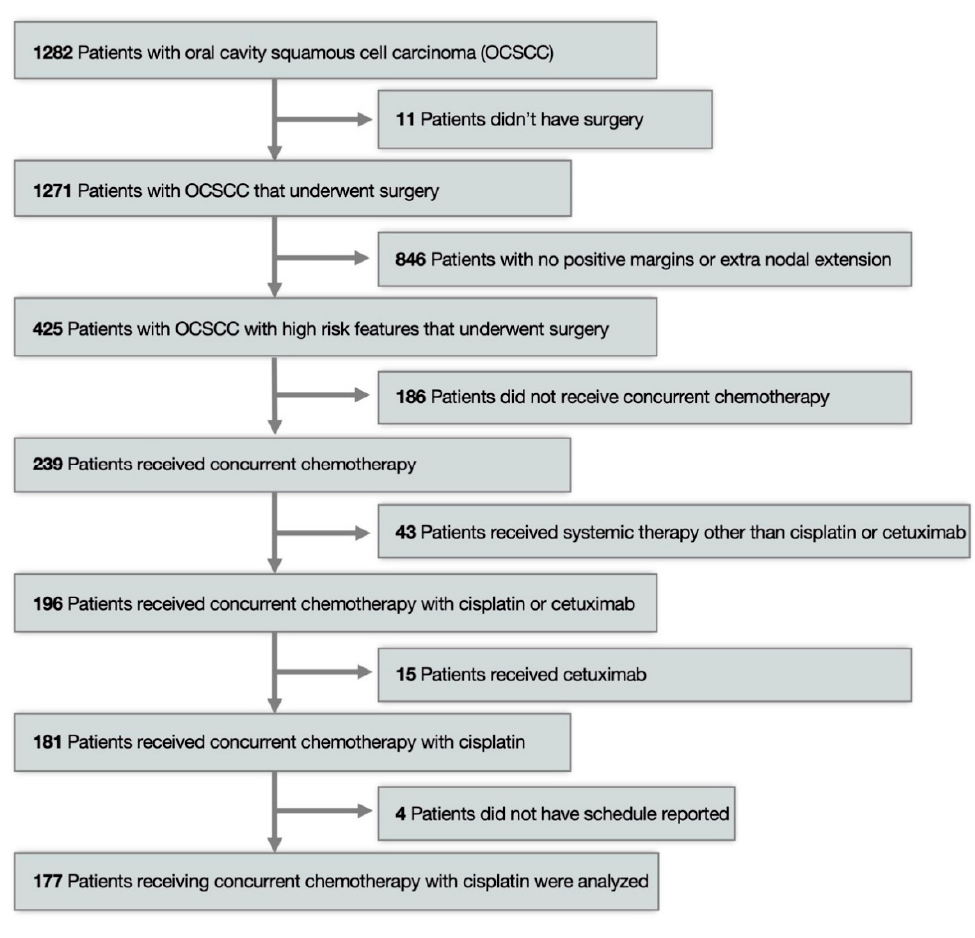
Figure 1. Patient Selection. Table 1. Patient characteristics.